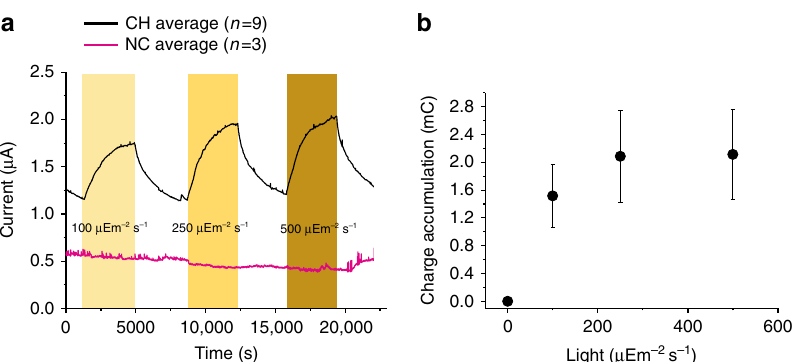
Fig. 3 Effect of light intensity on anodic photocurrent produced by the hybrid BPV system. a Current output measured over 6 h with three periods of light and darkness (1 h each). Light periods indicated by the yellow bars. Black trace for inkjet-printed Synechocystis on printed CNT anode and magenta trace for control experiments without the printed cells. Number of repeats is indicated in parenthesis. b Saturation curve for the current outputs as presented in the a . For each period of light (100, 250 and 500 µ E m − 2 s − 1 ), the current was integrated over time. The charge attributable to dark current over the same time was subtracted from the total charge during the light periods and plotted vs. the photon fl ux. Each data point is the result of 9 replicates and the standard error is shown as error